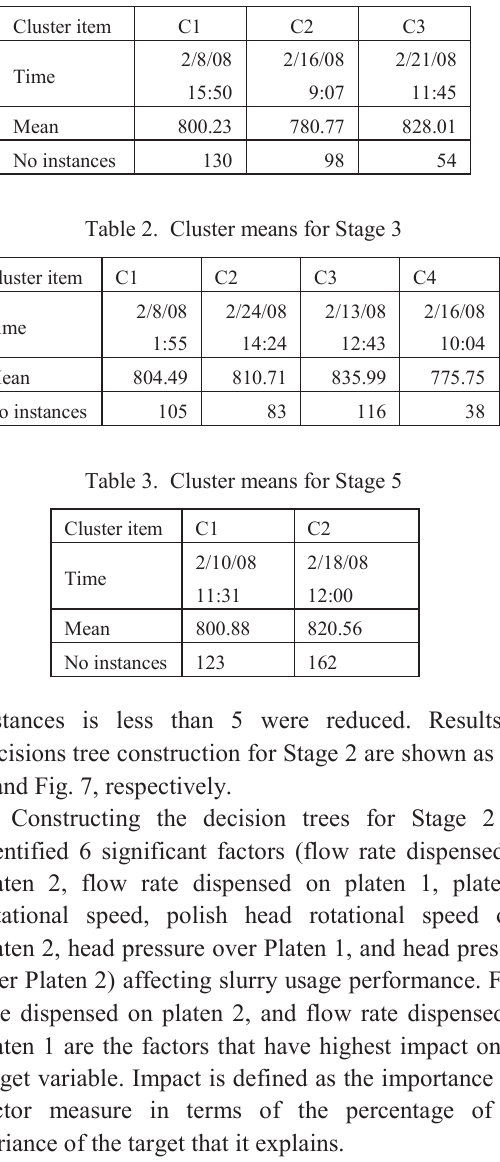
Table 1. Cluster means for Stage 2